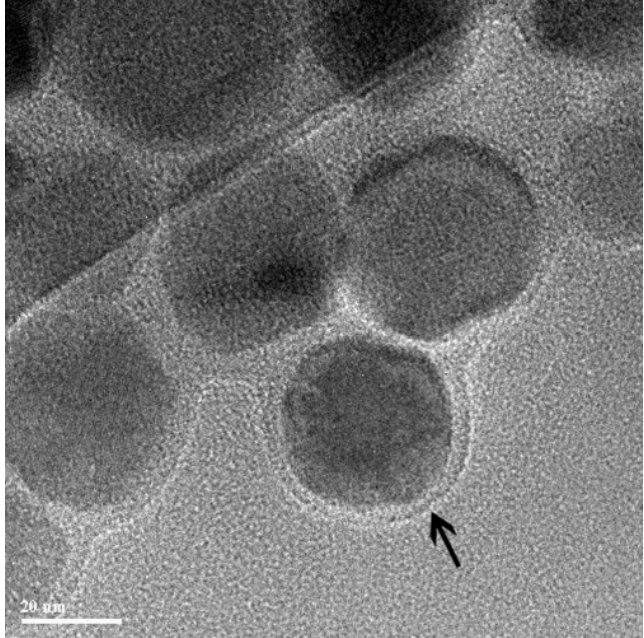
Figure 4. TEM image of bacterial magnetic particles enveloped by the cytoplasmic membrane (arrow). Adapted with permission from [101]. Copyright John Wiley and Sons, 2007.